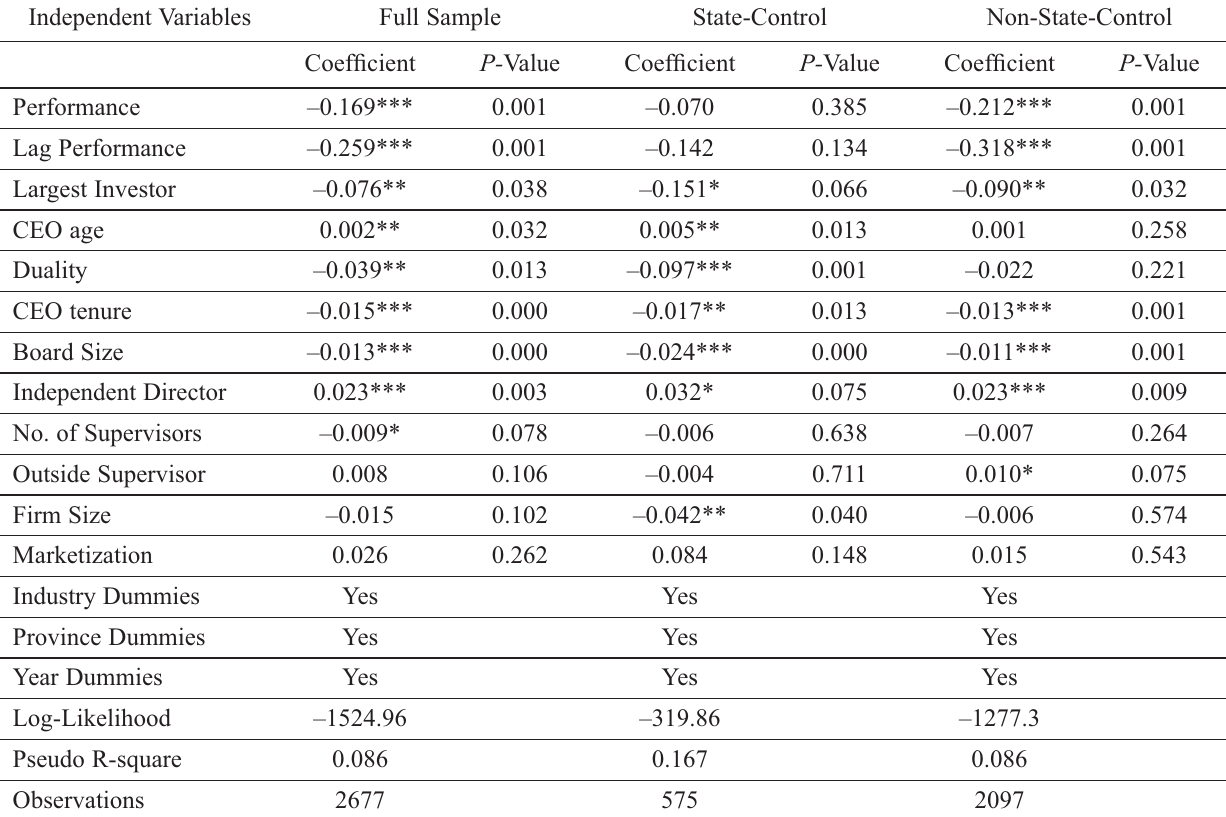
Table 7. Probit regression analysis of forced CEO turnover at the publicly listed fi rms in China The models are estimated using fi rm-level data of the fi rms listed on the Shanghai or Shenzhen stock exchanges in China during the period 1999–2002. State-controlled fi rms are fi rms of which the state is the largest shareholder, while non-state- controlled fi rms are fi rms of which the state is not the largest shareholder. The dependent variable is forced CEO turnover. Performance is measured with ROA. Lag(performance) is the one-year lagged performance (ROA). Largest Investor